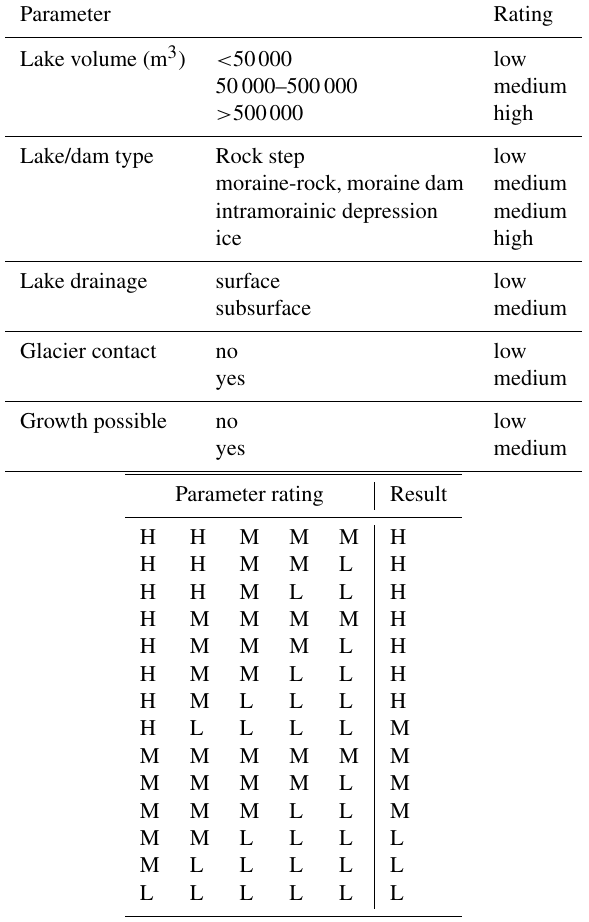
Table 3. Inherent susceptibility parameters and ratings of lakes. The scheme on the right shows possible combinations of parameter rat- ings (H – high, M – medium, L – low) and the resulting suscepti- bility. Note that this simplifying table serves as a guideline for the susceptibility estimate and that even medium resulting susceptibil- ity means a lake is dangerous and may burst and cause